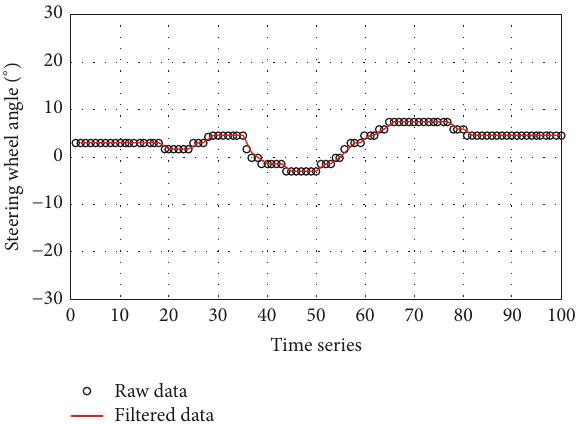
Figure 6: Relative speed, relative distance, and relative angle changes during car